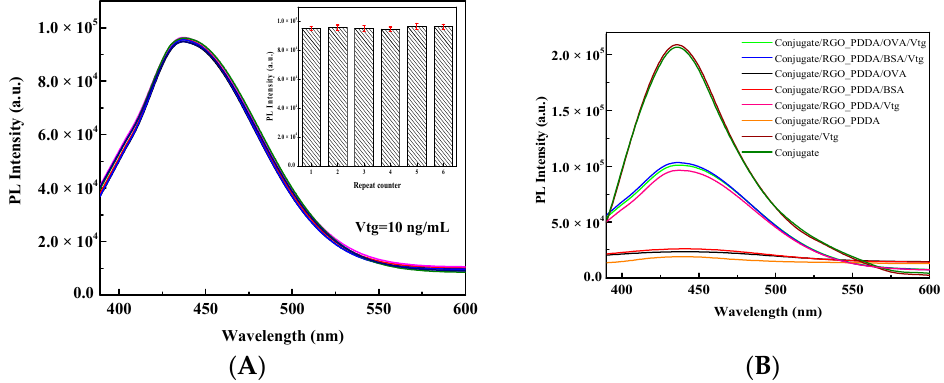
Figure 7. ( A ) Reproducibility and ( B ) immunosensing behavior against specific (Vtg) and nonspecific antigen (BSA and OVA). ( A ) shows the addition of the same amount of Vtg (10 ng/mL) into six parallel samples of Anti-Lv-mAb/CQDs/RGO_PDDA; and in ( B ), the concentration of Vtg is 10 ng/mL, and the concentrations of OVA and BSA is 100 times that of Vtg.